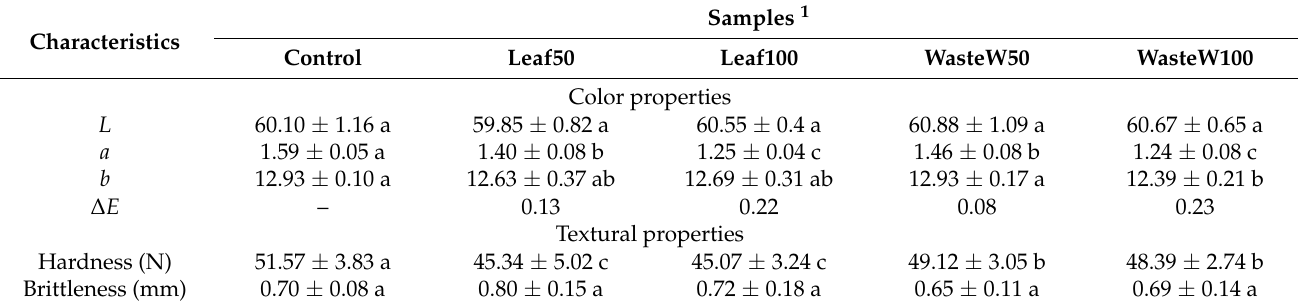
Table 3. Textural and color properties of GF